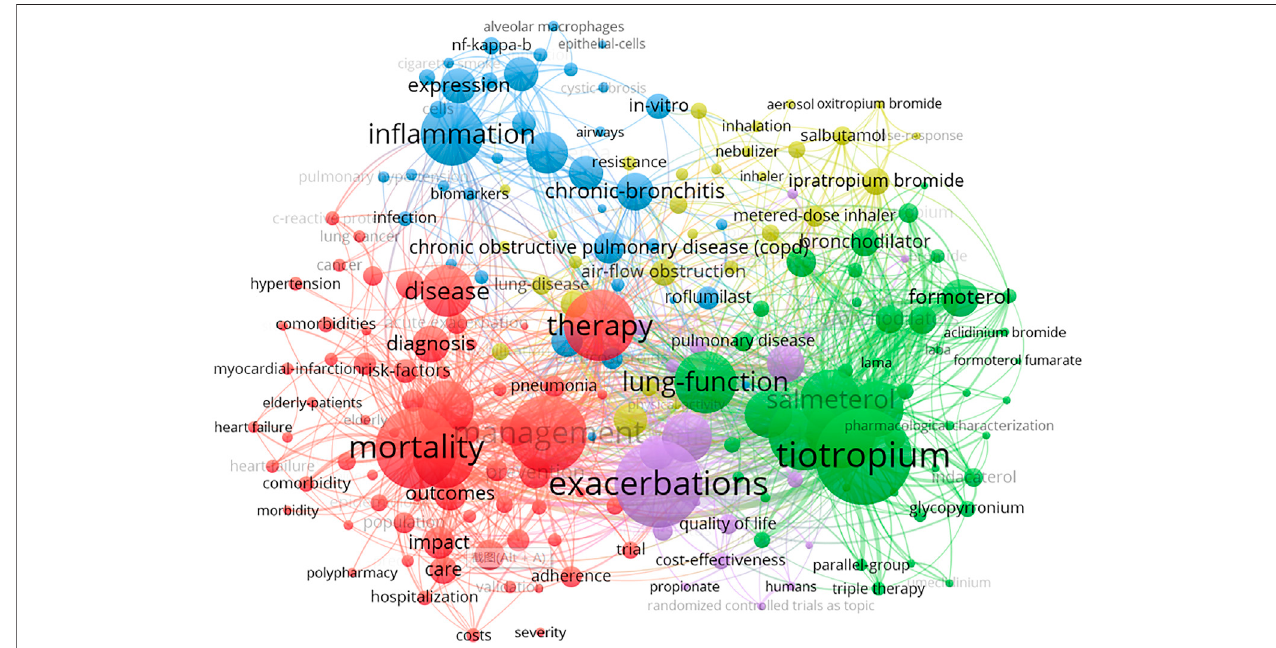
FIGURE 10 | Keywords analysis of COPD drugs-related studies that were published from 1980 to 2021.